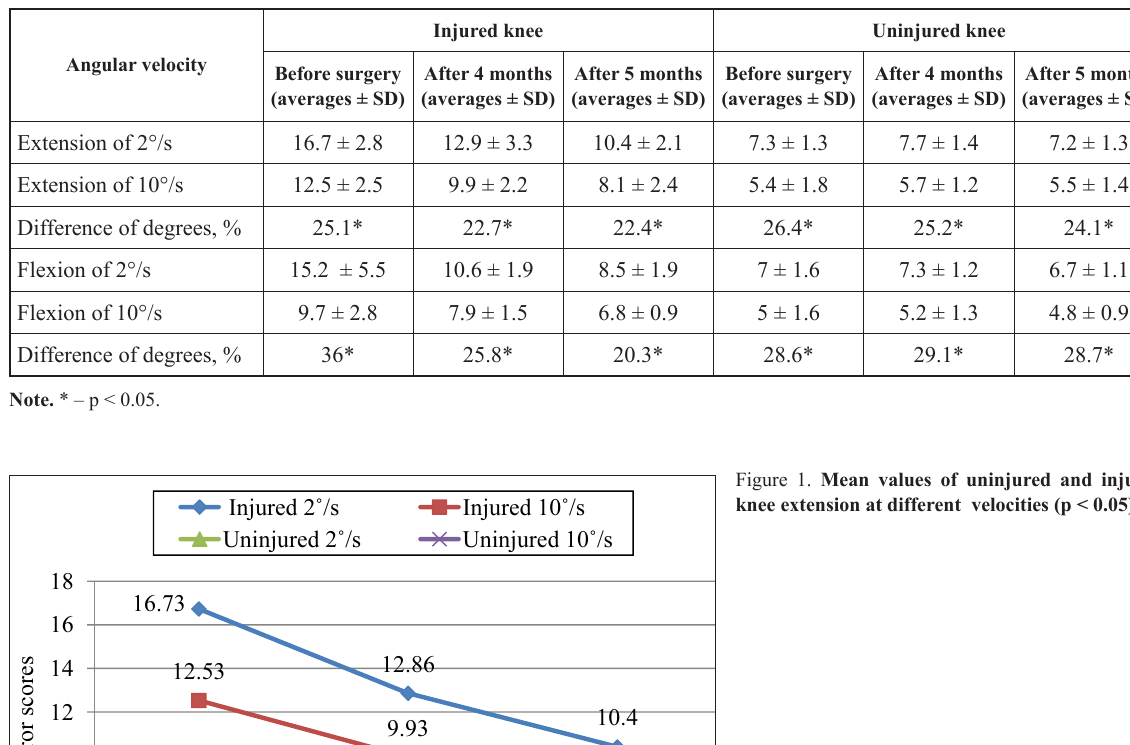
Table 3. Differences of degrees in JPS for mean error scores (averages ± SD) between two different angular velocities of 2°/s and of 10°/s